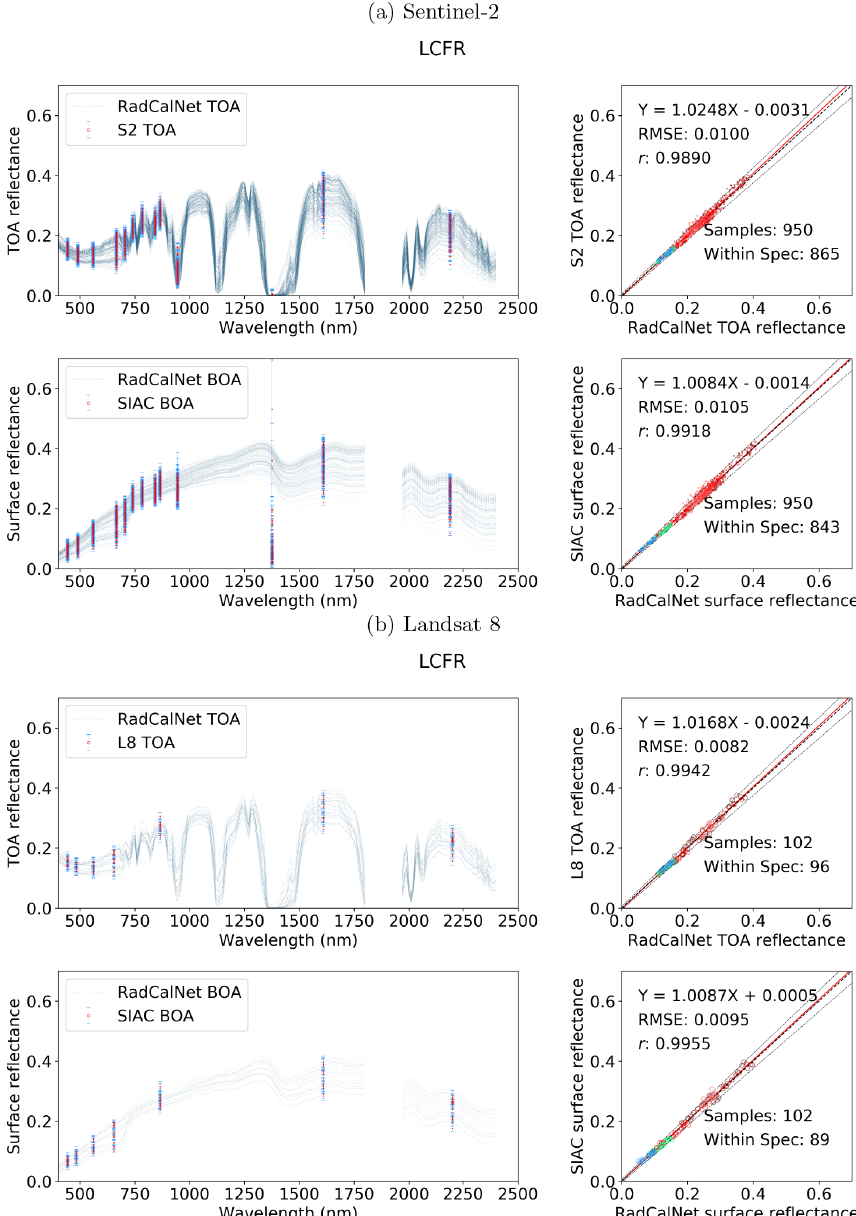
Figure 12. Same as Fig. 11 but for La Crau